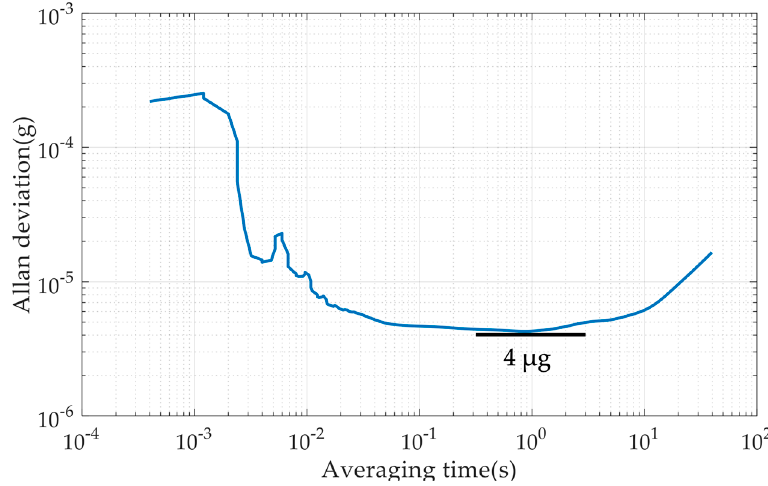
Figure 14. Results of the bias instability evaluation experiment.